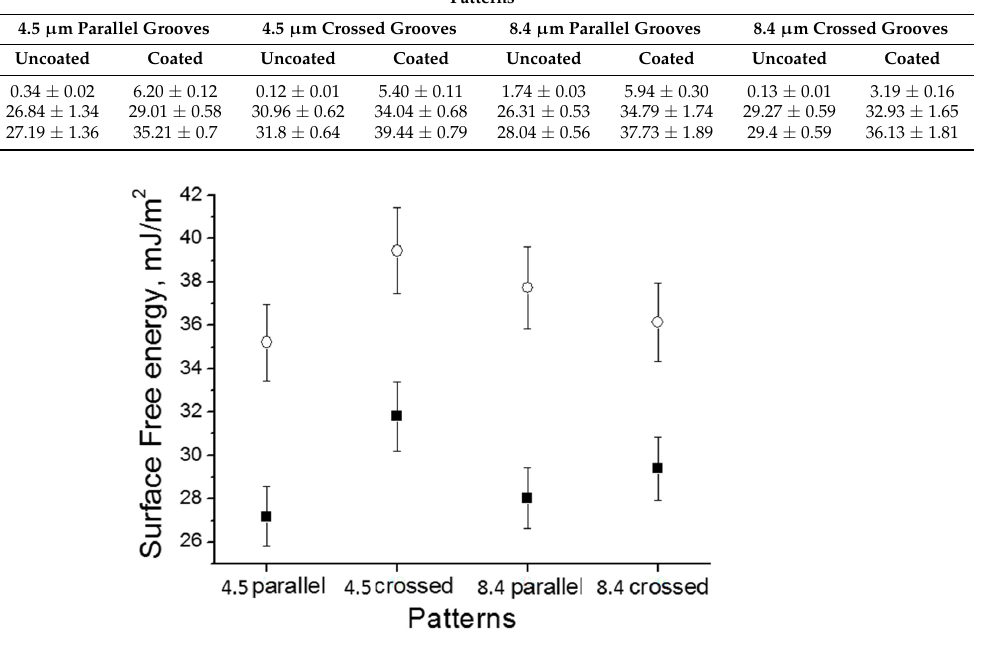
Figure 8. The surface free energy measurements for different patterned Ti surfaces: ■ —without a HA film, and ○ —with a HA film.